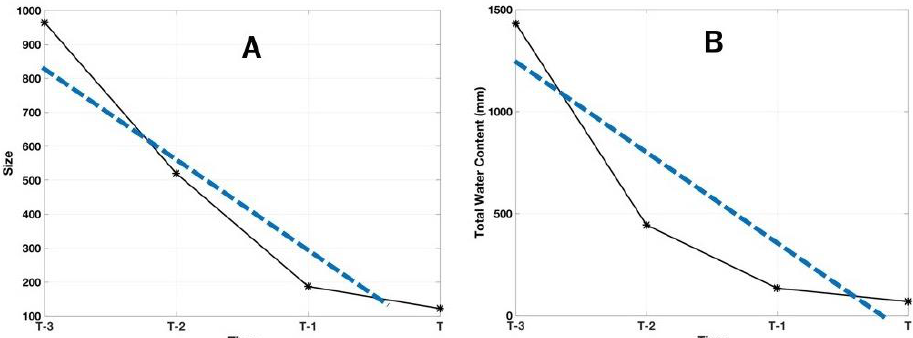
Figure 8. The trend of ( A ) the precipitation’s size and ( B ) the precipitation’s total water content. The calculated variables are presented with solid black lines, and linearly fitted results are shown with dashed blue lines.